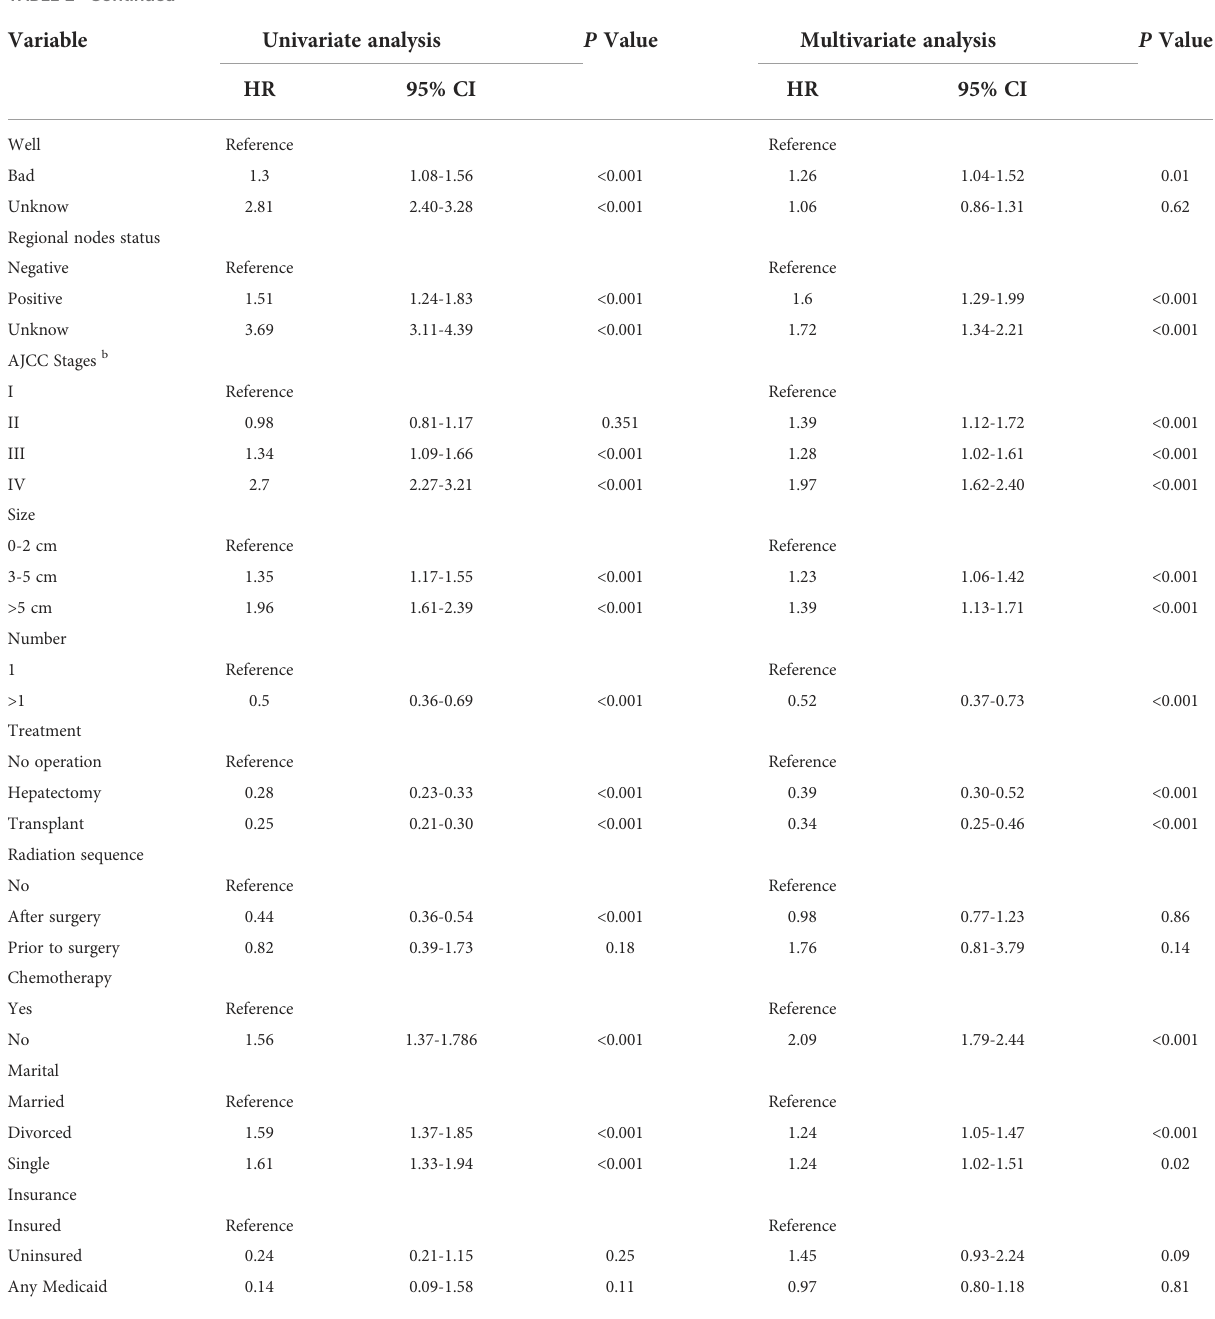
with ECCA, risk scores for each variable were derived based on patients ’ information. Second, all risk scores were added to fi nd the corresponding scores in line with the total scores. Finally, the probability of 1-, 2-, and 3-year CSS for patients with ECCA was determined by drawing a straight line on the last 3 rows.The C- index for the training and validation cohorts was 0.785 (95% CI: 0.741-0.792) and 0.776 (95% CI: 0.716-0.788), respectively.